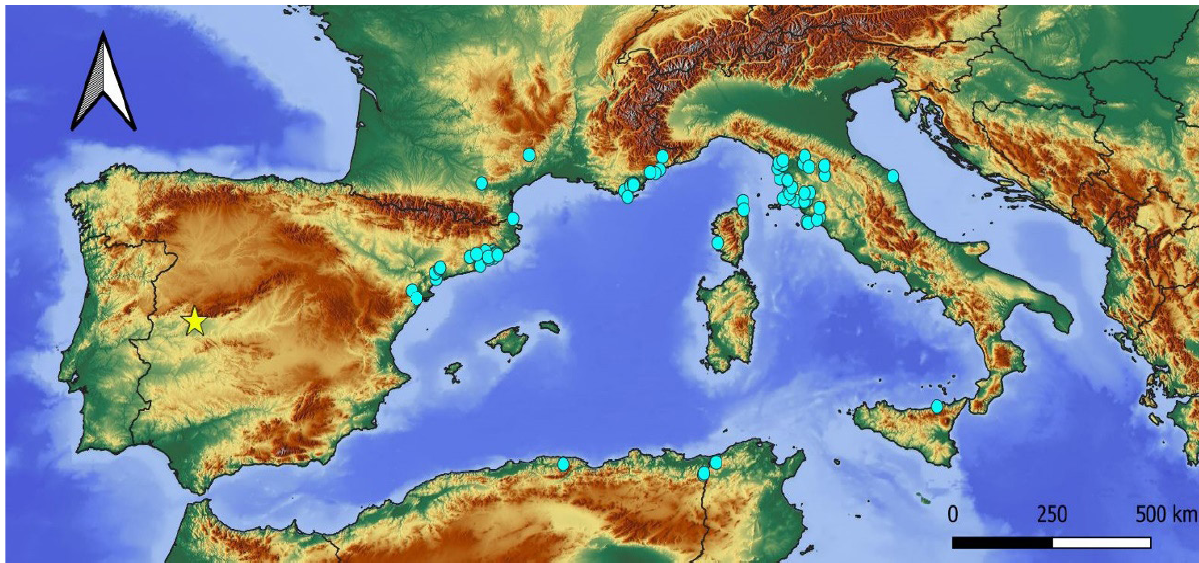
Figure 1. Distribution map of Carex olbiensis based on studied material (blue dots are the specimens from Appendix 1; yellow star is the new